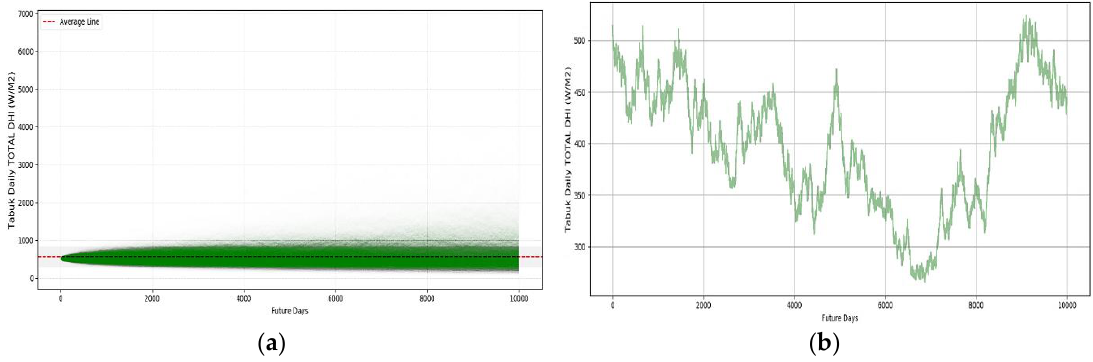
Figure 14. ( a ) Daily total solar DHI distributions for the north-western region, as predicted by MCS and BM, and ( b ) a one-day scenario for the solar DHI distribution prediction performance. Energies 2020 , 13 , x FOR PEER REVIEW